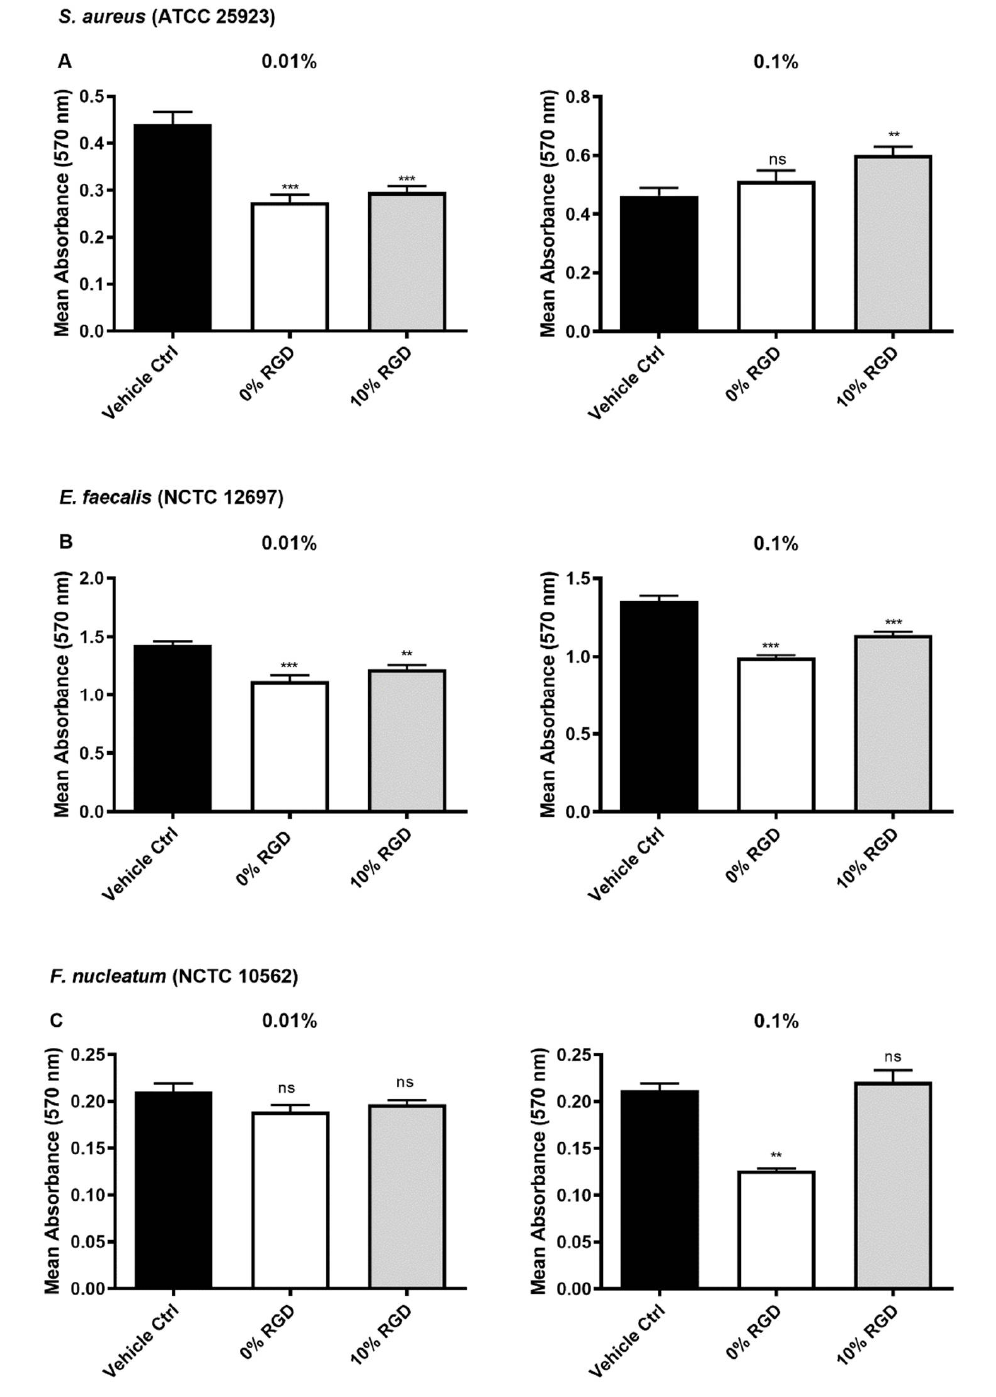
Figure 5. Biofilm inhibition by 0% RGD and 10% RGD soluble peptides, as determined by the crystal violet assay. ( A ) S. aureus , ( B ) E. faecalis and ( C ) F. nucleatum biofilm biomass following 24 h incubation with 0.01% and 0.01% w / v peptides. All comparisons were made with vehicle controls. Data are from three experiments, with at least three replicates per experiment . S. aureus and E. faecalis data analysed by one-way ANOVA with Dunnett’s correction for multiple comparison testing. F. nucleatum data analysed by a Kruskal–Wallis test with Dunn’s correction for multiple comparison testing. ns: non-significant ( p > 0.05), **: p ≤ 0.01, ***: p ≤ 0.001.